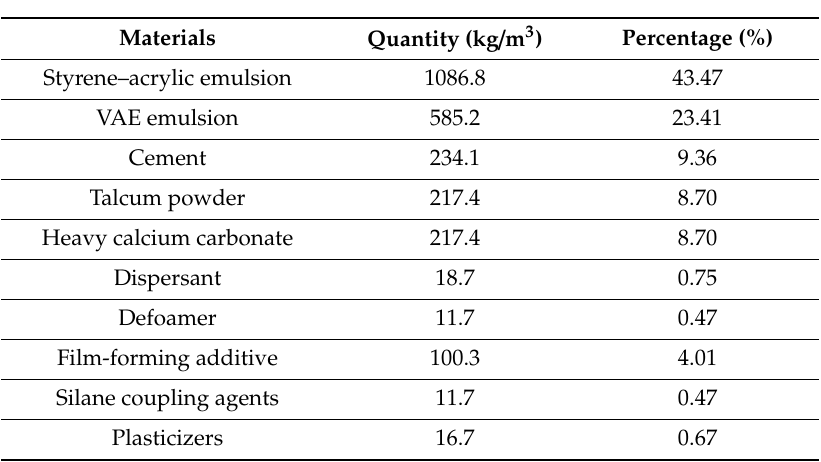
Table 2. Composition ratio of PCFC mixture